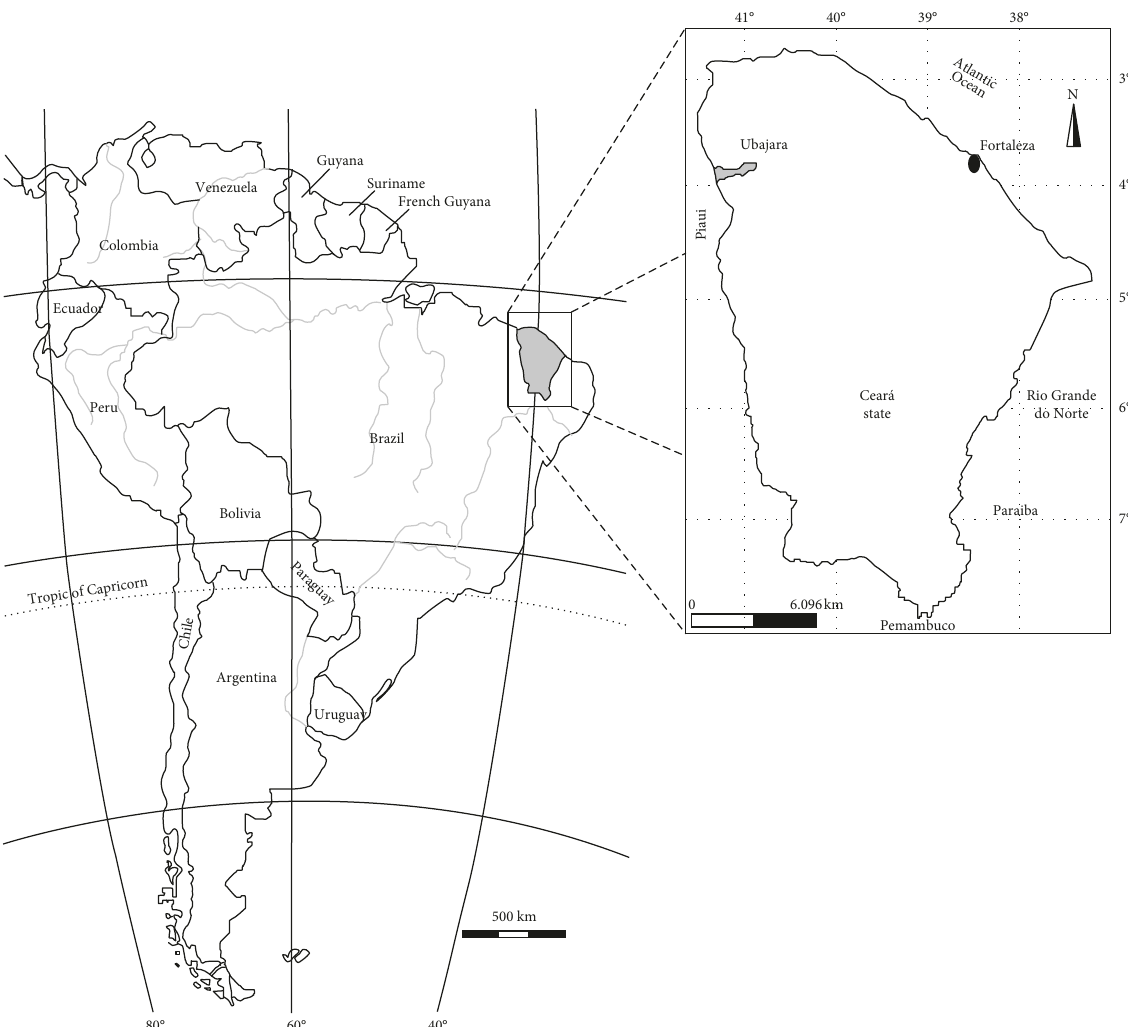
Figure 1: Map of South America, showing the Cear´a state and the Ubajara town. Modified from Oliveira et al.